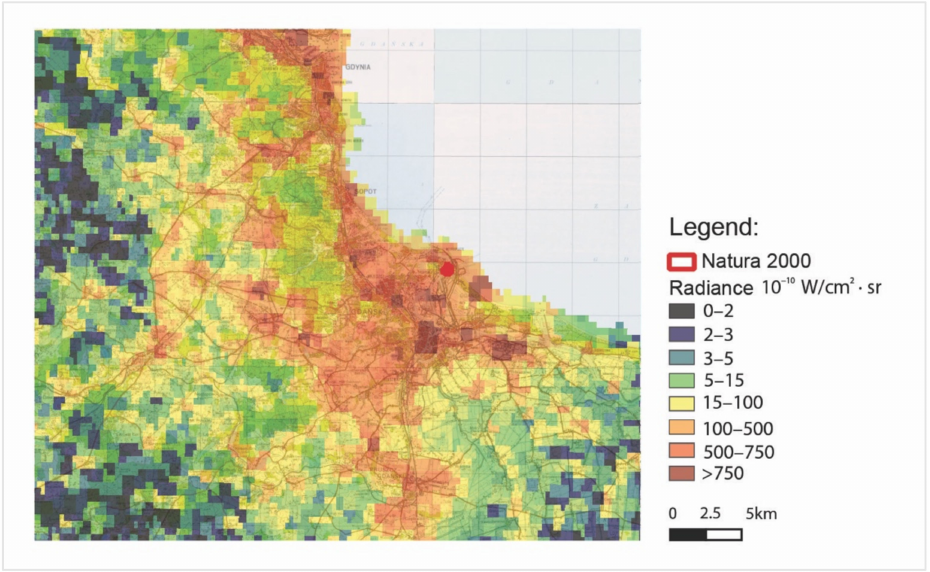
Figure 15. Radiance map taken on 28 August 2020 showing Gda´nsk and its